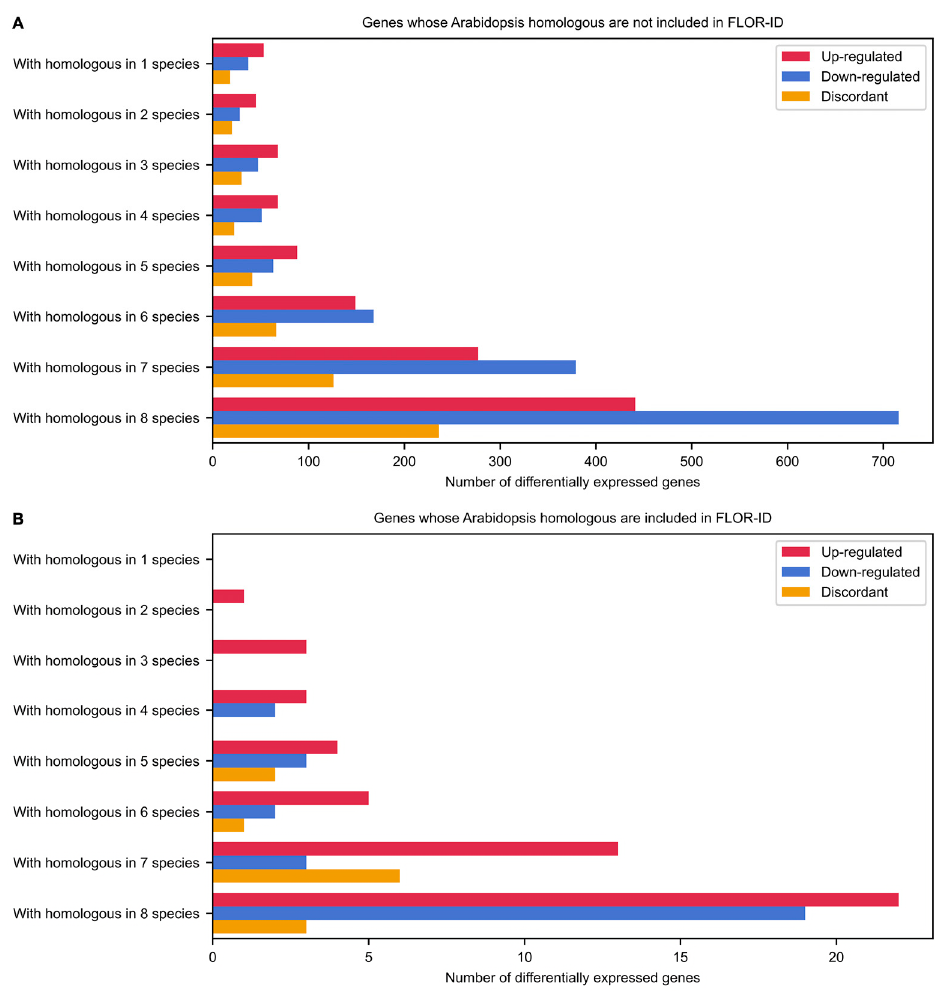
Figure 6. Evolutionarily conserved genes involved in inflorescence meristem development. Genes whose Arabidopsis homologous are not ( A ) and are included ( B ) in the FLOR-ID database as flowering-related genes [18]. The number of up-regulated and down-regulated genes common to both PHA1037 and PHA0595 cultivars are shown in red and blue, respectively. The number of genes with discordant expression profiles between PHA1037 and PHA0595 cultivars are plotted in orange. Details of these orthologous genes can be found in Tables S19 and S20.